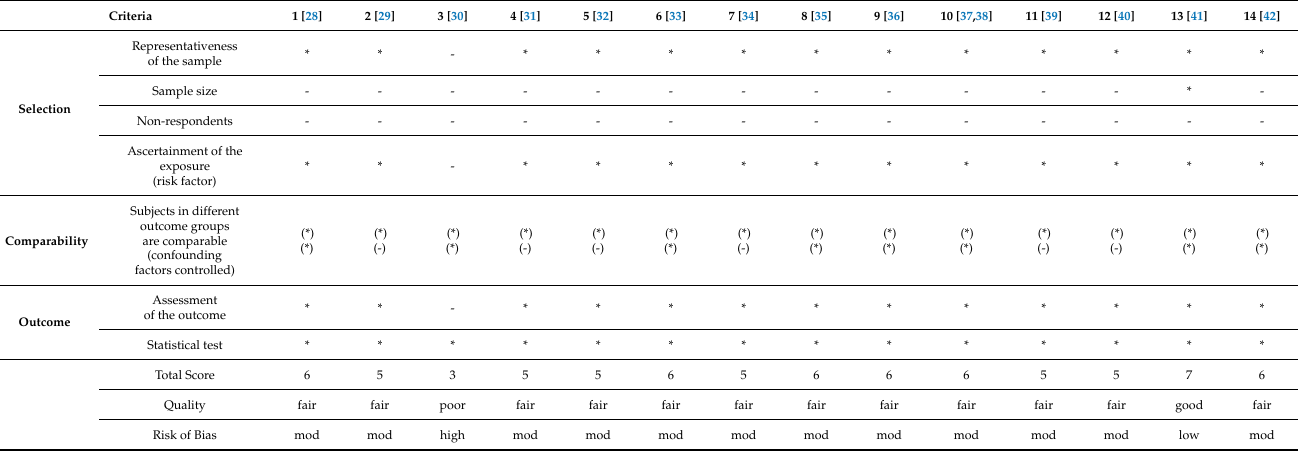
Table 6. Quality assessment of case–control studies for α -synuclein and DJ-1 according to the customized Newcastle–Ottawa Scale